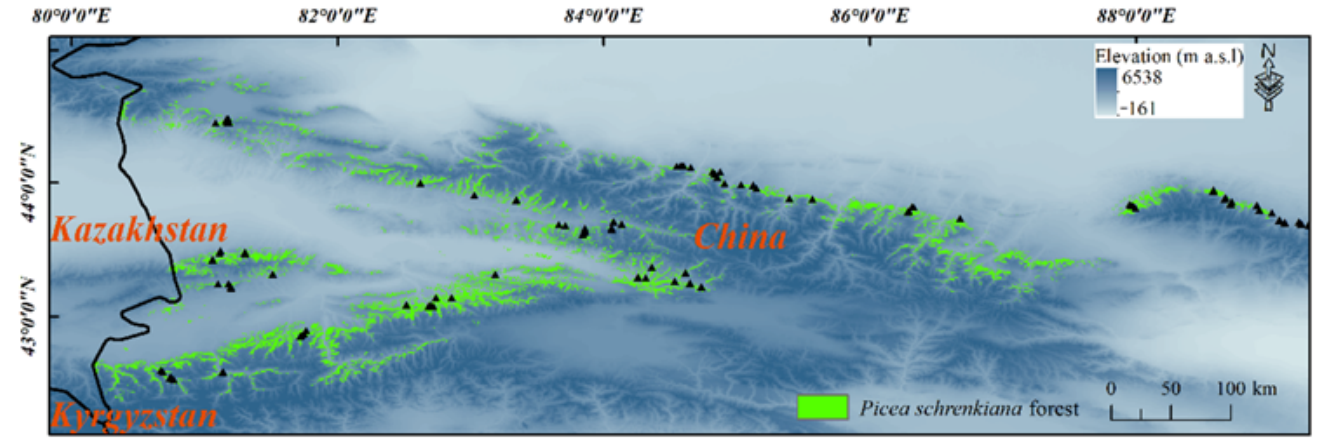
Figure 1. Location of the study area (Tianshan Mountains) and sampling sites (black triangles).